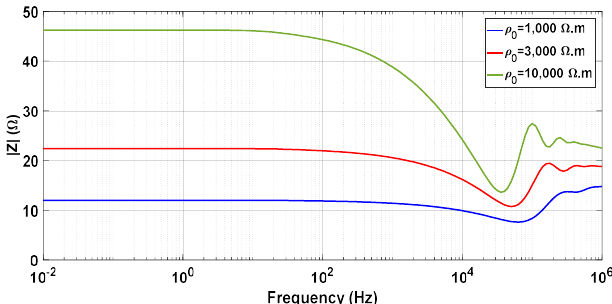
Figure 5. Magnitude of the harmonic grounding